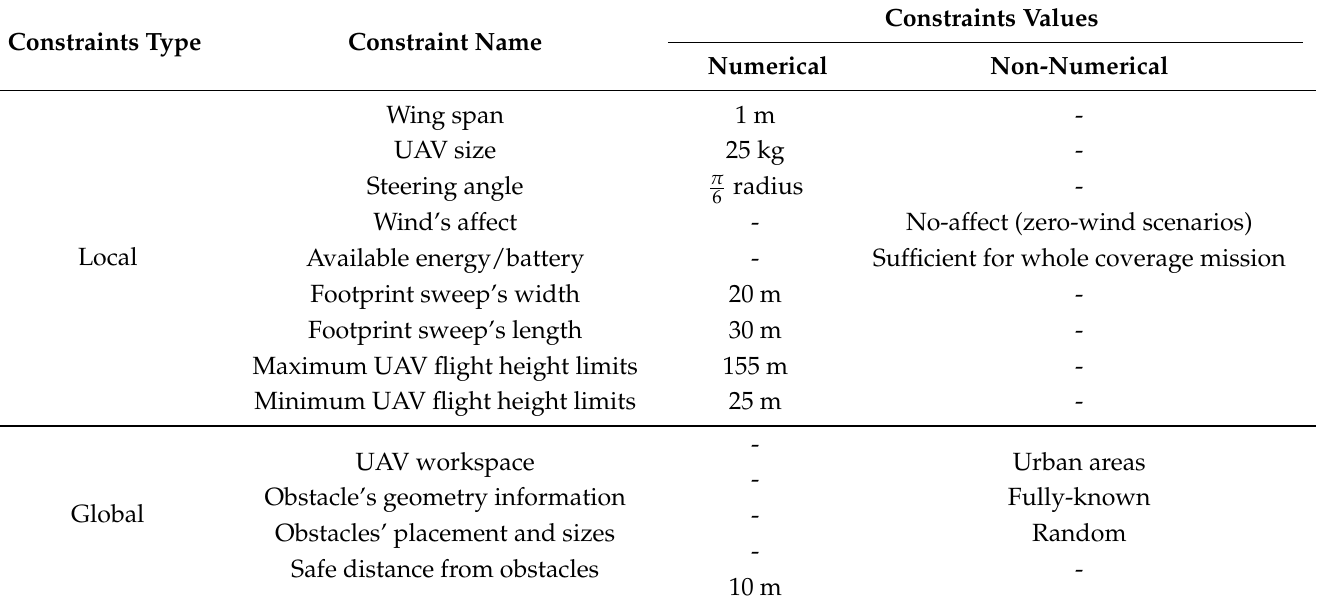
Table 2. Numerical/Non-numerical values of the global (urban environment) and local (UAV itself) constraints.